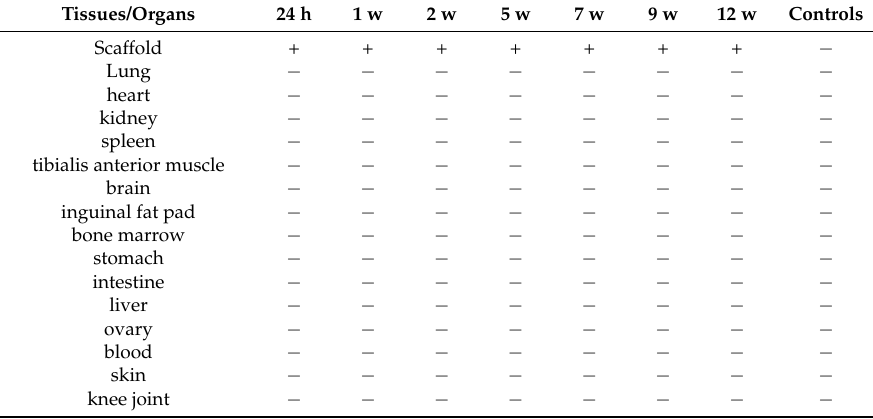
Table 1. Biodistribution of h BMMSCs using the quantitative polymerase chain reaction (qPCR) technique, for 12 weeks. Controls: cell-free scaffolds; (+), detection of human RNAse P gene; ( − ), no detection of human RNAse P gene.